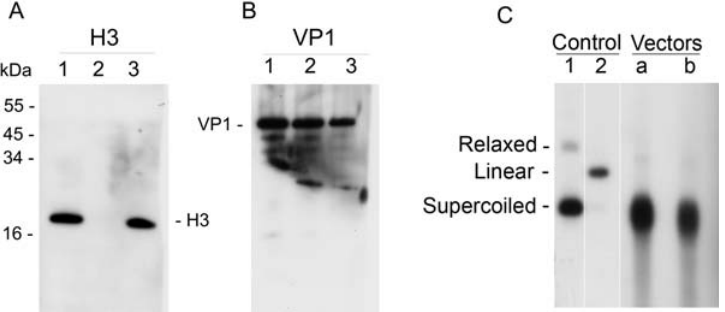
Figure 5. Analysis of the particles. A,B-Proteins were separated by elecrtrophoresis in Tricine buffer on 16% polyacrylamide gel. Western blotting was performed with polyclonal antibody against histone H3 (Upstate) (A) and against VP1 (B). M–size marker; 1–Nuclear extracts used in the packaging reaction; 2–In vitro assembled particles, fraction 9 of Fig. 4. 3–wild type SV40. C-Analysis of the packaged DNA. Particles purified by ultrafiltration were treated with Tris base (200 mM) in presence of 25 mM EGTA and 25 mM DTT for 1 hr at 37 u C. DNA was extracted by phenol- chloroform treatment in presence of 1% SDS, and analyzed by Southern blotting with pGL3-control as a probe.